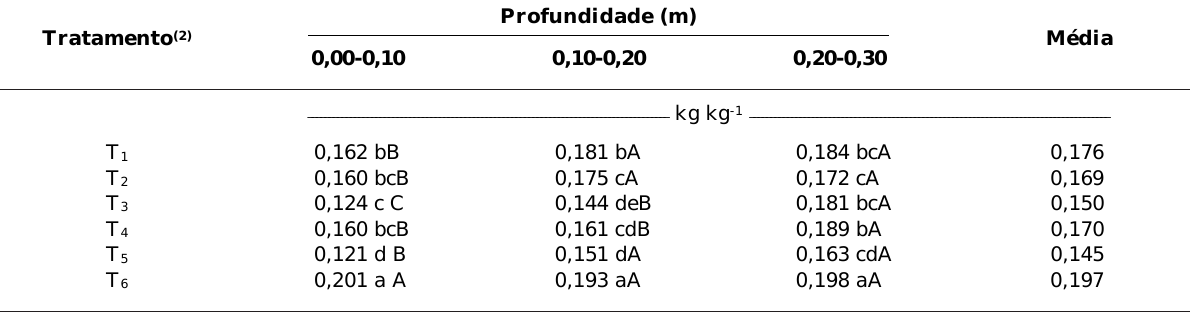
- Sistema tradicional de cultivo de arroz; 1 - Sistema de cultivo de arroz x rotação de culturas; 3 - Sucessão de culturas: soja (sistema 5 - 6